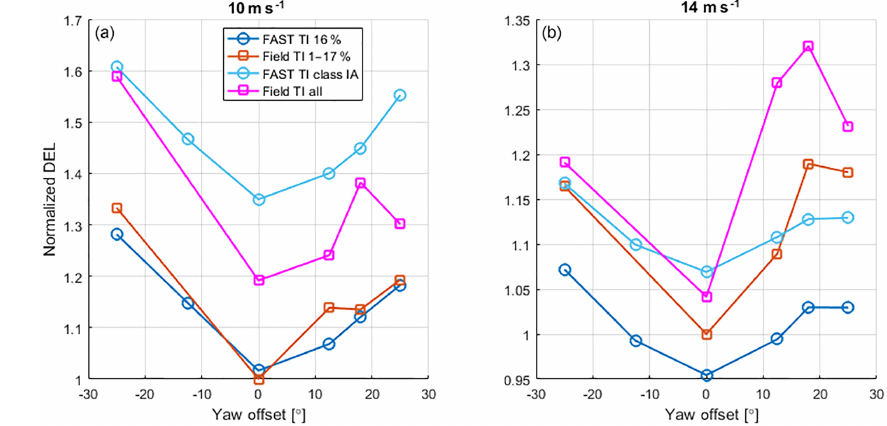
Figure 11. TI effect on the blade FBM DEL. Comparison between simulated (circles) and measured (squares) values of the loads for various TI levels, as a function of yaw offset and for U hub = 10ms − 1 (a) and U hub = 14ms − 1 (b) . The loads are normalized by the mean value at 0 ◦ yaw offset from the field data filtered to a TI range of 1 to 17%. Labels in the legend are the same as in Fig.